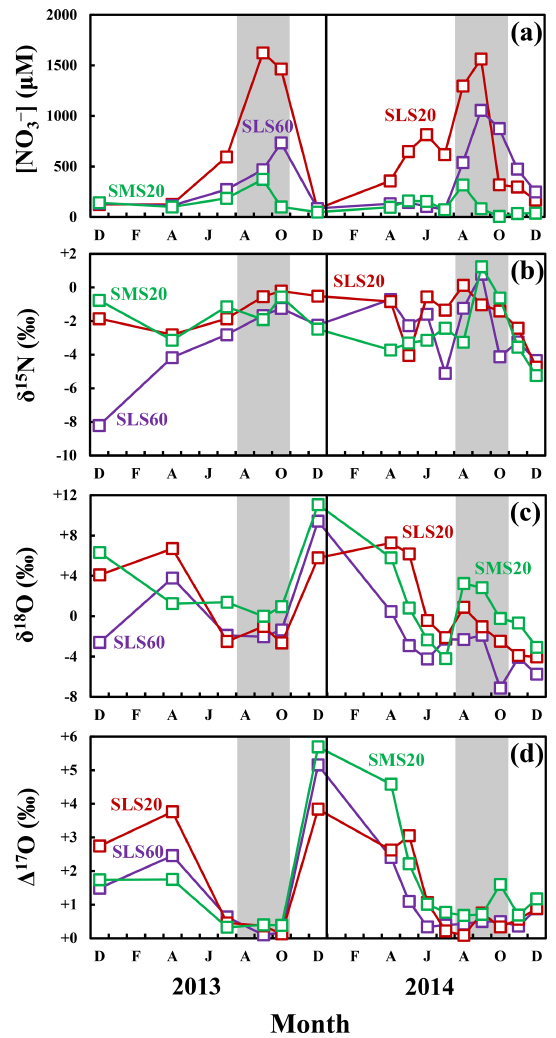
Figure 5. Seasonal variations in the concentrations of soil nitrate (a) at SLS 20 (red squares), SLS 60 (purple squares), and SMS 20 (green squares), together with those in the values of δ 15 N (b) , δ 18 O (c) , and (cid:49) 17 O (d) of each soil nitrate during 2013– 2014 (modified from Nakagawa et al., 2018). The periods used to esti- mate the isotopic compositions (from August to October) are pre- sented in gray. The error bars are smaller than the sizes of the sym- bols.